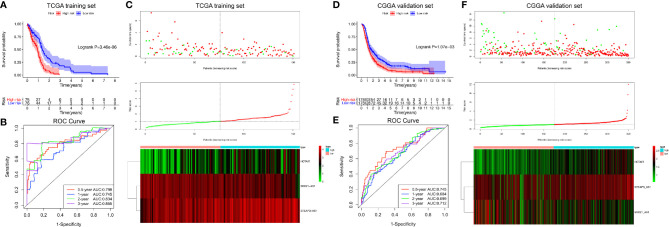
Risk score analysis of the GBM exo-lncRNA signature in the training set from TCGA and validation set from CGGA. (A–C) Analysis performed using the training set from TCGA; (D–F) CGGA validation set analysis. (A, D) Kaplan-Meier survival curve of high-risk and low-risk groups. The table below shows the number of patients at risk at different time points. (B, E) Time‐dependent ROC curves based on risk score level. (C, F) Risk score analysis of the GBM exo-lncRNA signature. Upper panel: patient survival status and time distributed by risk score. Middle panel: risk score curve of the exo-lncRNA signature. Bottom panel: heatmap of SOX21-AS1, HOTAIR, and STEAP3-AS1 expression in GBM samples. The colors from red to green indicate expression level from high to low. The dotted line indicates the individual inflection point of the risk score curve, by which the patients were categorized into low-risk and high-risk groups. ROC: receiver operating characteristic.